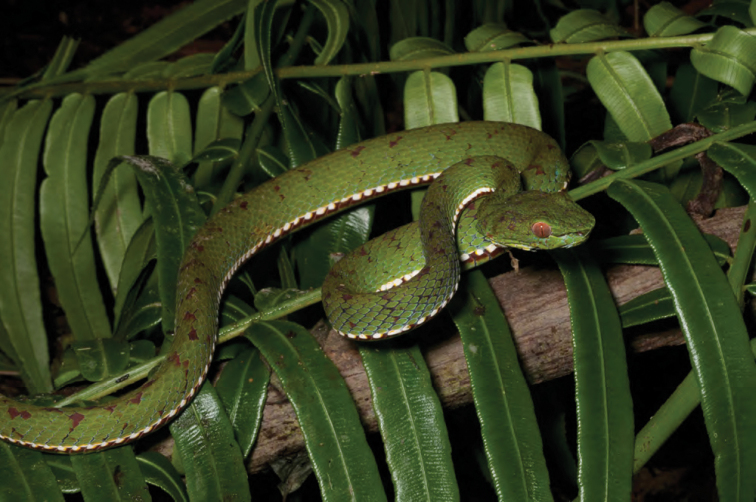
Trimeresurus flavomaculatus (KU 330049)from mid-elevation, Mt. Cagua, Location 1b. Photo: RMB.